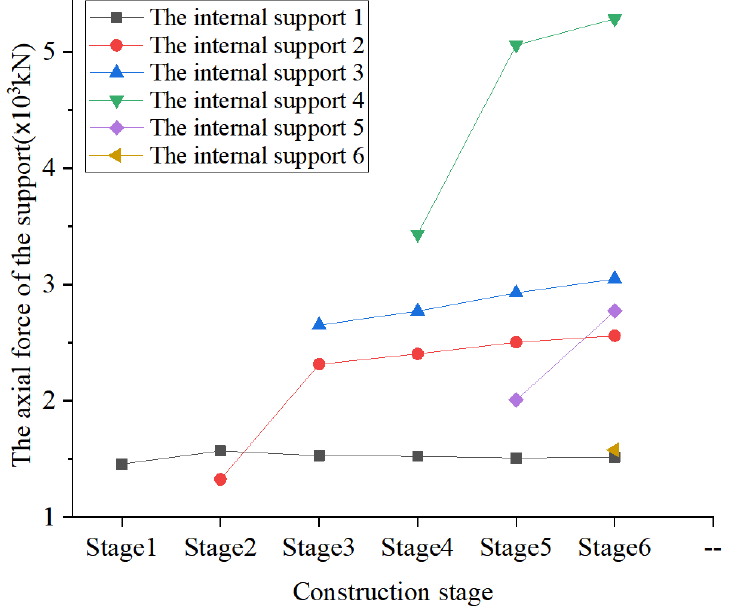
Figure 26. The axial force of the support in the central district.